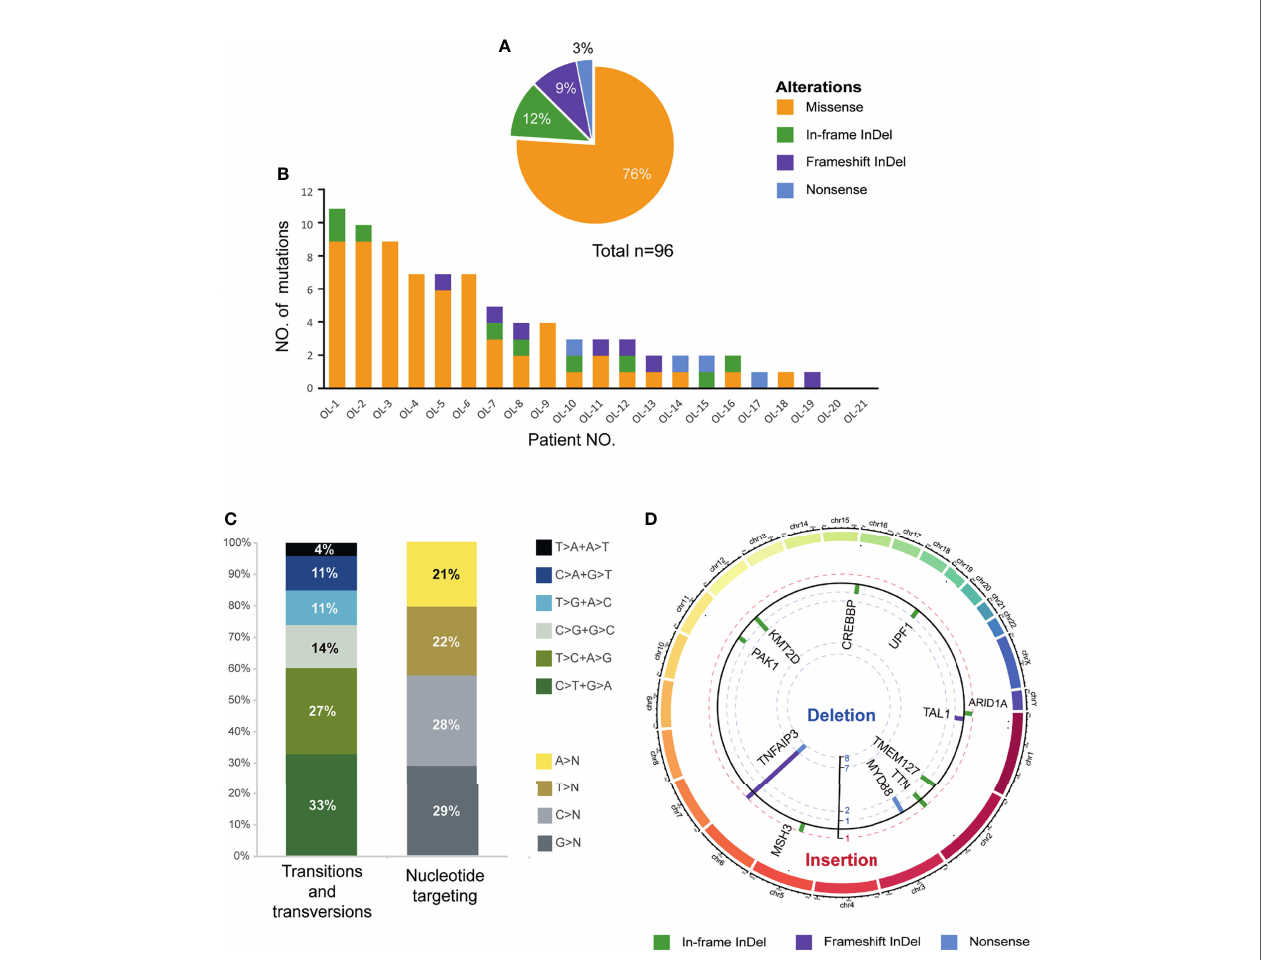
FIGURE 1 | Overview of somatic mutational signature. (A) Pie charts showed the breakdown of different nonsynonymous mutation types in coding regions, including missense SNVs, frameshift insertions/deletions, in-frameshift insertions/deletions, and nonsense SNVs. (B) Number and type of nonsilent somatic mutations identi fi ed in the 21 discovery coding genomes. (C) The pattern of nucleotide substitutions in the discovery genomes revealed a predominance of transitions over transversions (47:29, ratio of 1.62) and a preferential targeting of G and C nucleotides (58% affecting G/C compared with 42% affecting A/T nucleotides). (D) Circo plot representing indels and nonsense mutations (n=23) mapped to different chromosomes scaled by the mutated sample counts (y-axis showed the unique samples count). The columns outside track represented the gene symbols with in-frameshift/frameshift insertions, while the columns inside track represented the in- frameshift/frameshift deletions or nonsense